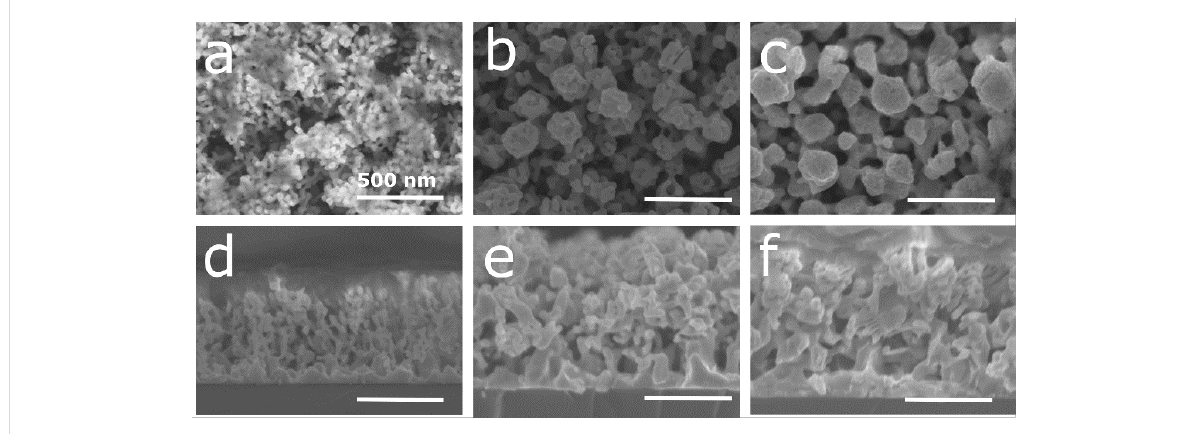
Figure 5: (a–c) Plan view and (d–f) cross-section SEM images of the Ag–Al alloy thin film dealloyed for 60 min in H 3 PO 4 at 10 wt % with an initial composition of (a, d) 18, (b, e) 30, and (c, f) 36 atom % of Ag. Scale bar: 500 nm.